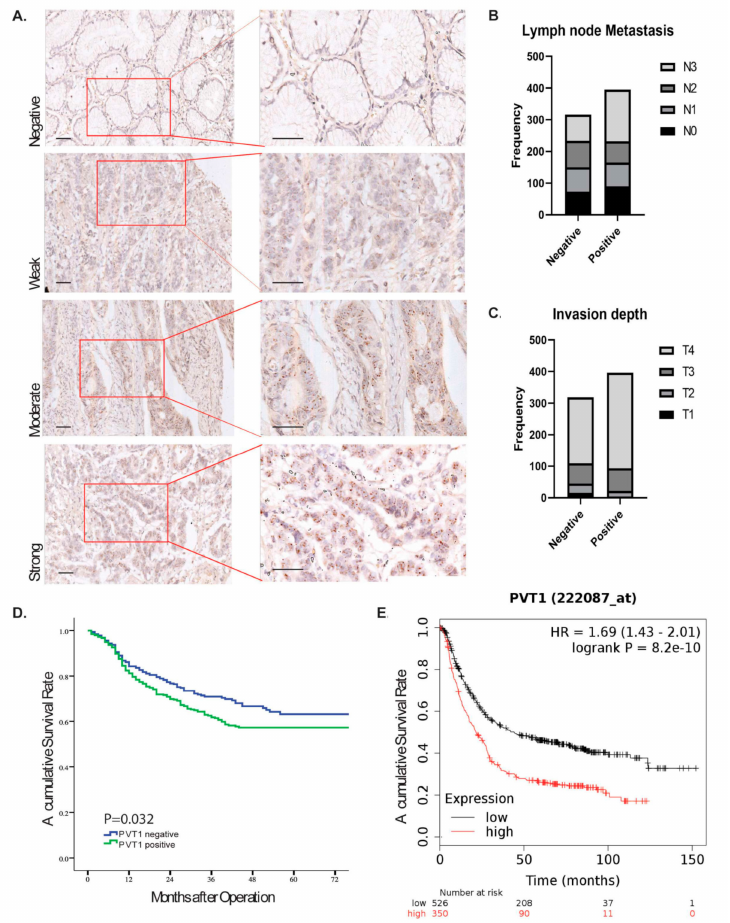
Figure 2. Positive expression of PVT1 in TMAs. ( A ) R-Scope ISH was performed using the PVT1 probe in a GAC TMA that consisted of 792 pairs of primary tumor tissues and adjacent normal tissues. Scale bars = 40 µ m ( B ) PVT1 positivity in GAC tissues was correlated with lymph node